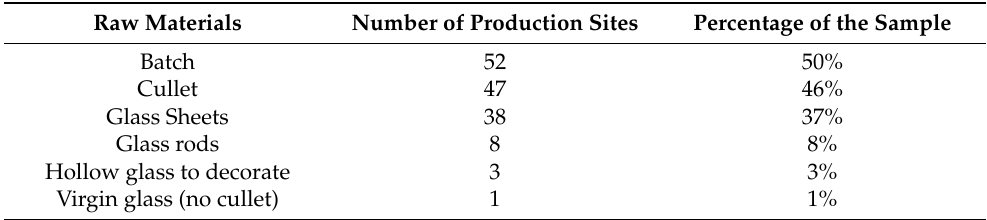
Table 2. Type of raw material.